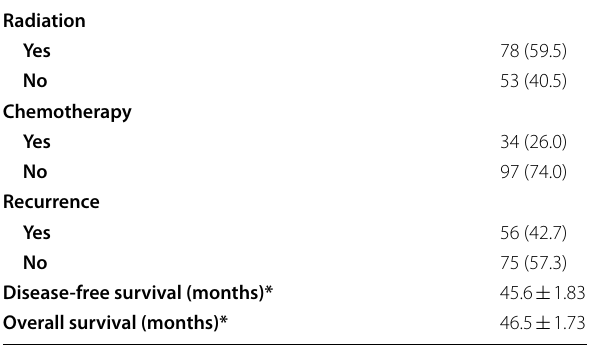
Table 2 Adjuvant treatment and survival of patients with tongue squamous cell carcinoma